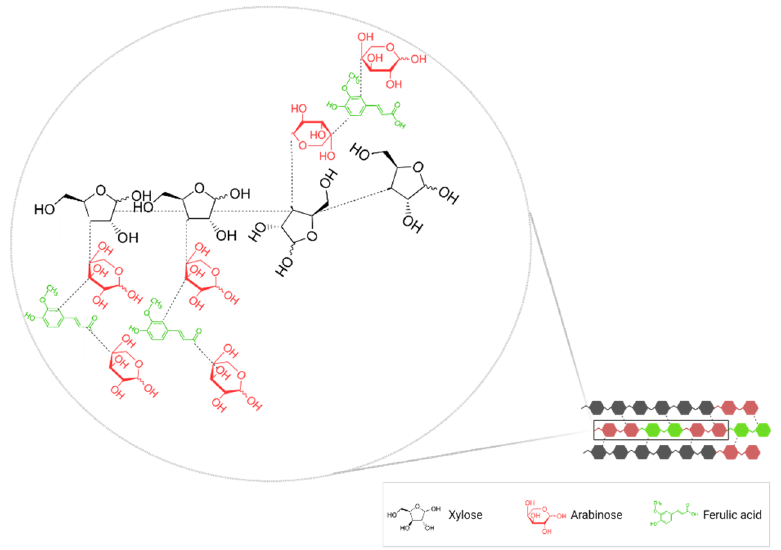
Figure 2. Cell-wall bound ferulic acid in cereal